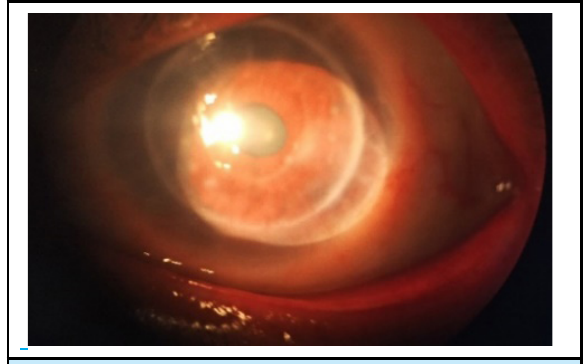
Figure 3. 1 week follow up with no epithelial defect but hazy